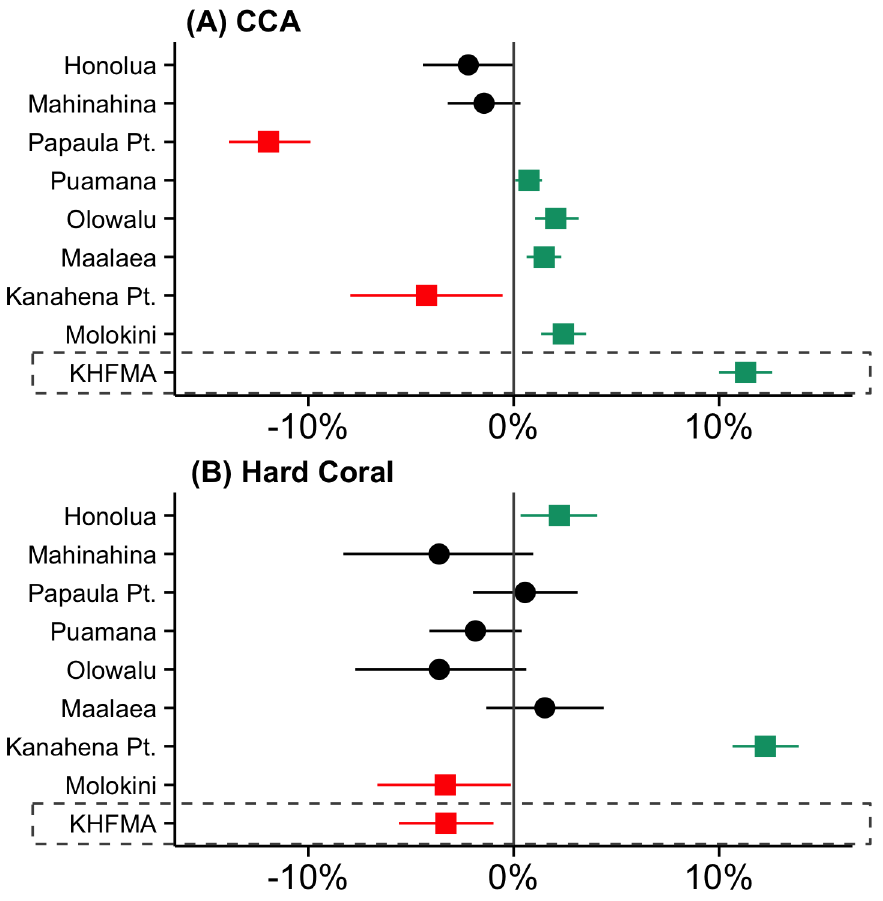
Fig 7. Net change between ‘ before ’ (2008 – 9) and ‘ after ’ (2014 – 15) for cover of (a) crustose coralline algae (CCA) and (b) hard coral at KHFMA and comparison locations surveyed by Hawaii DAR. Data points represent the net absolute change in % cover from ‘ before ’ to ‘ after ’ , and lines are 95% quantile range (95%QR) of that change. 95% QR not overlapping zero are taken as evidence of a significant difference between time periods, shown as a green square (increase) or red square